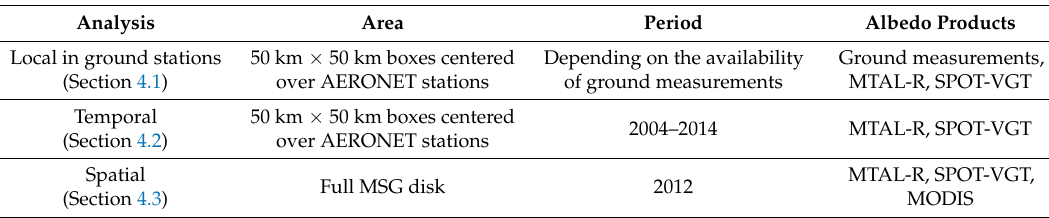
Table 3. Validation